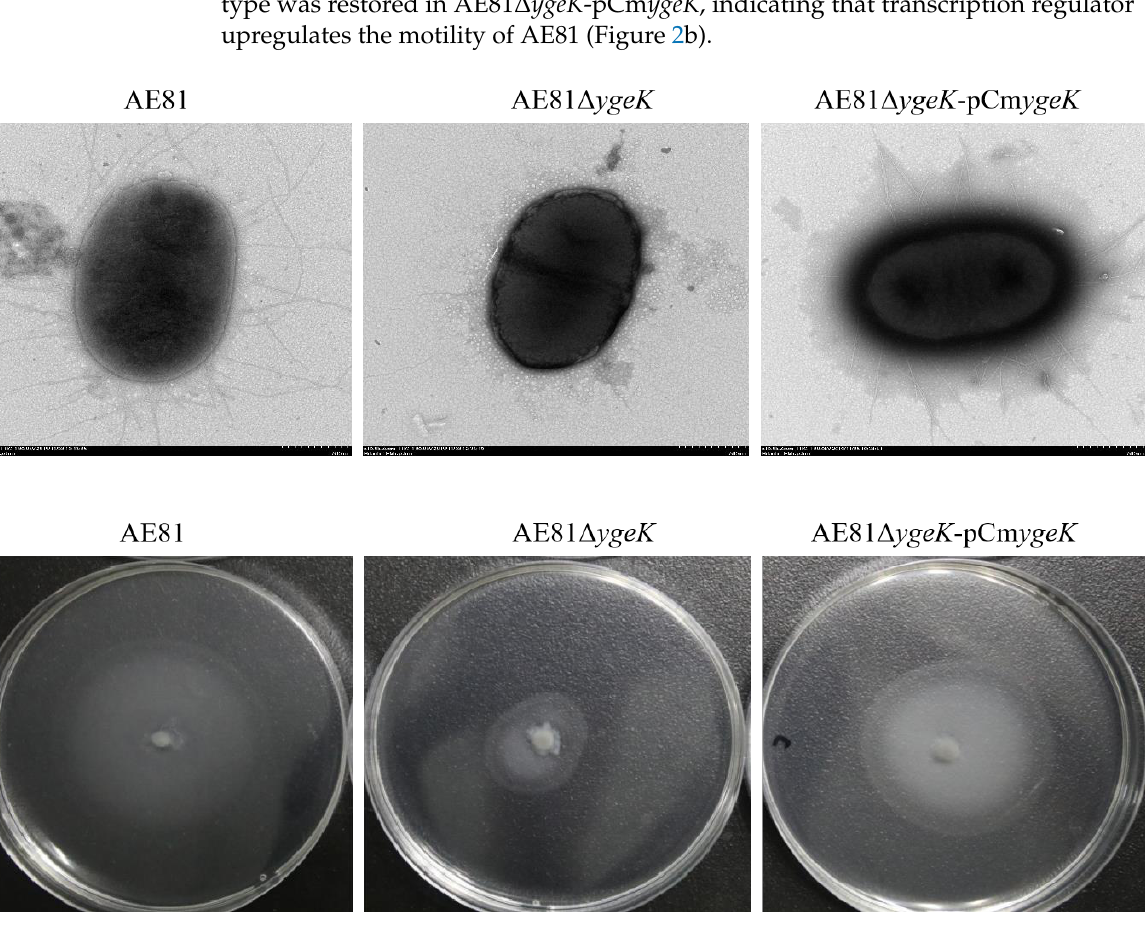
Figure 2. ( a ) Bacterial micromorphology of AE81, AE81Δ ygeK , and AE81AE81Δ ygeK -pCm ygeK observed by transmission electron microscopy (×10,000). ( b ) Motilities of AE81, AE81Δ ygeK , and AE81AE81Δ ygeK -pCm ygeK on semisolid medium.